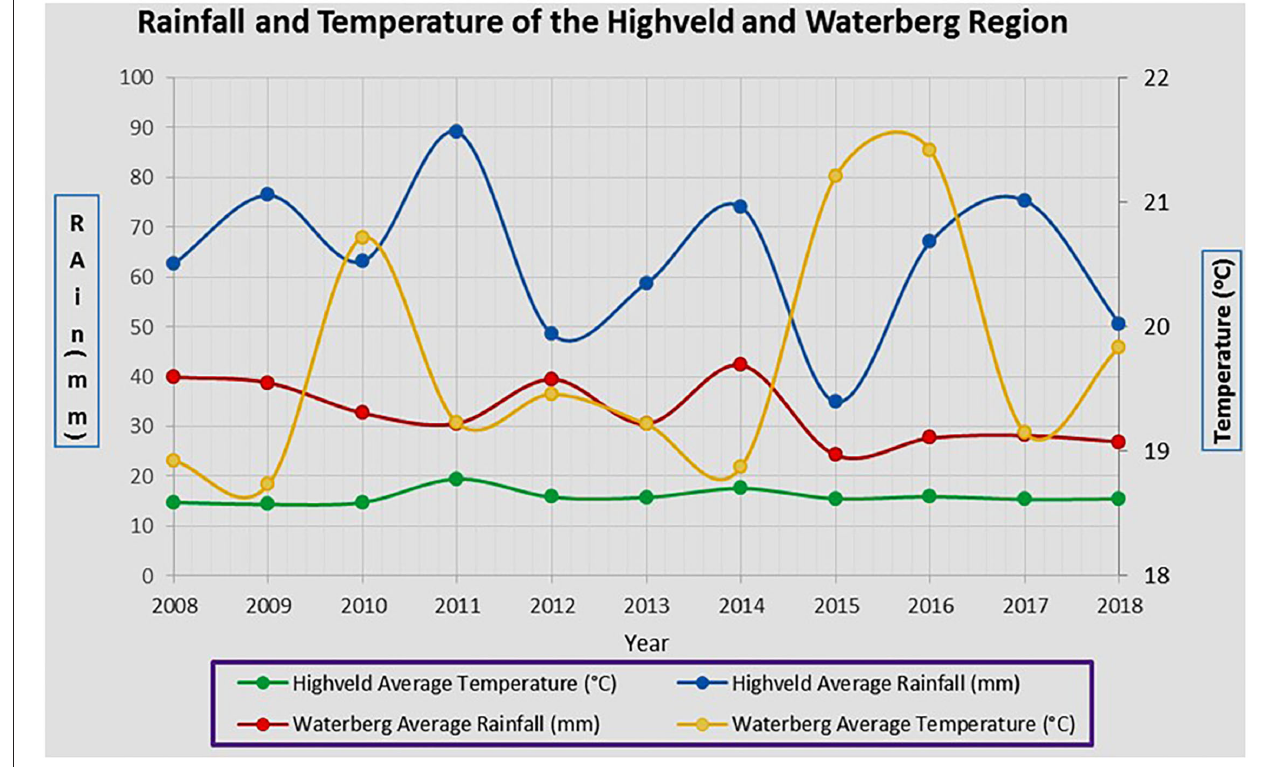
FIGURE 6 | Comparison of the temperature and rainfall interactions. Source: Data from South African Weather Services (SAWS) (2019).